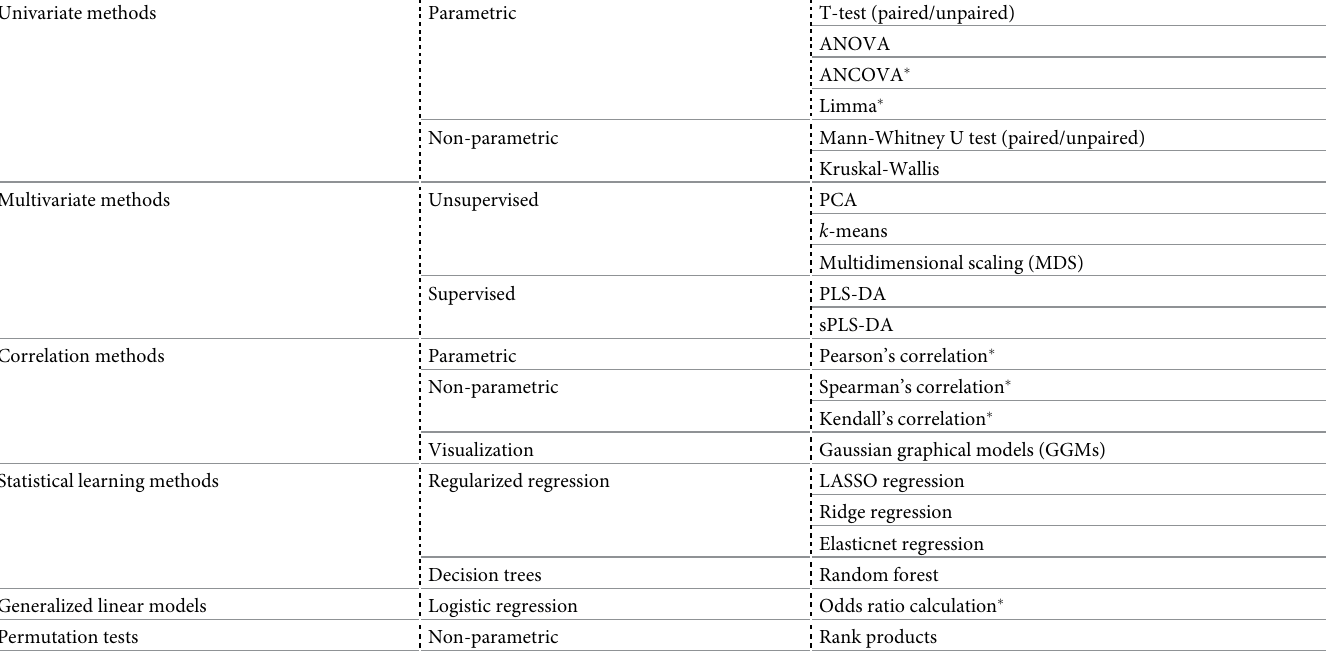
Table 1. Statistical methods provided in POMAShiny. � Methods that allow the use of covariates. Univariate